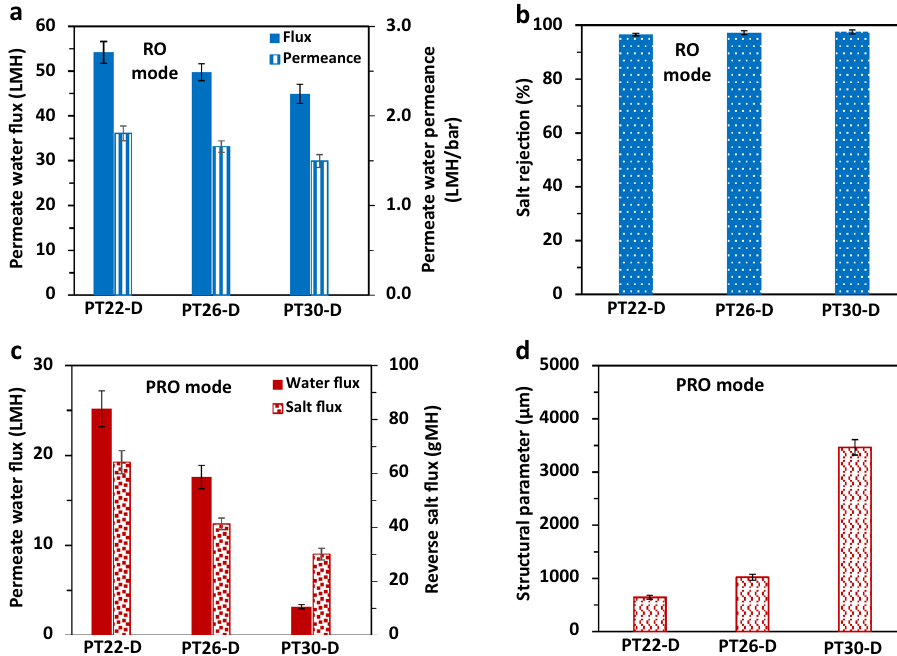
Fig. 7 The RO and PRO performances and structural parameters of the optimal PES-TFC hollow fi ber membranes. a , b Permeate water fl ux, water permeance, and salt (NaCl) rejection of the membranes tested under the RO mode using a 0.3 mol/L NaCl solution as the feed at 30 bar. c , d Permeate water fl ux, reverse salt fl ux, and the structural parameters of the membranes tested under the PRO mode using a 1.2 mol/L NaCl solution as the draw solution at 20 bar. Error bars represent mean absolute errors based on at least three replicate experiments.